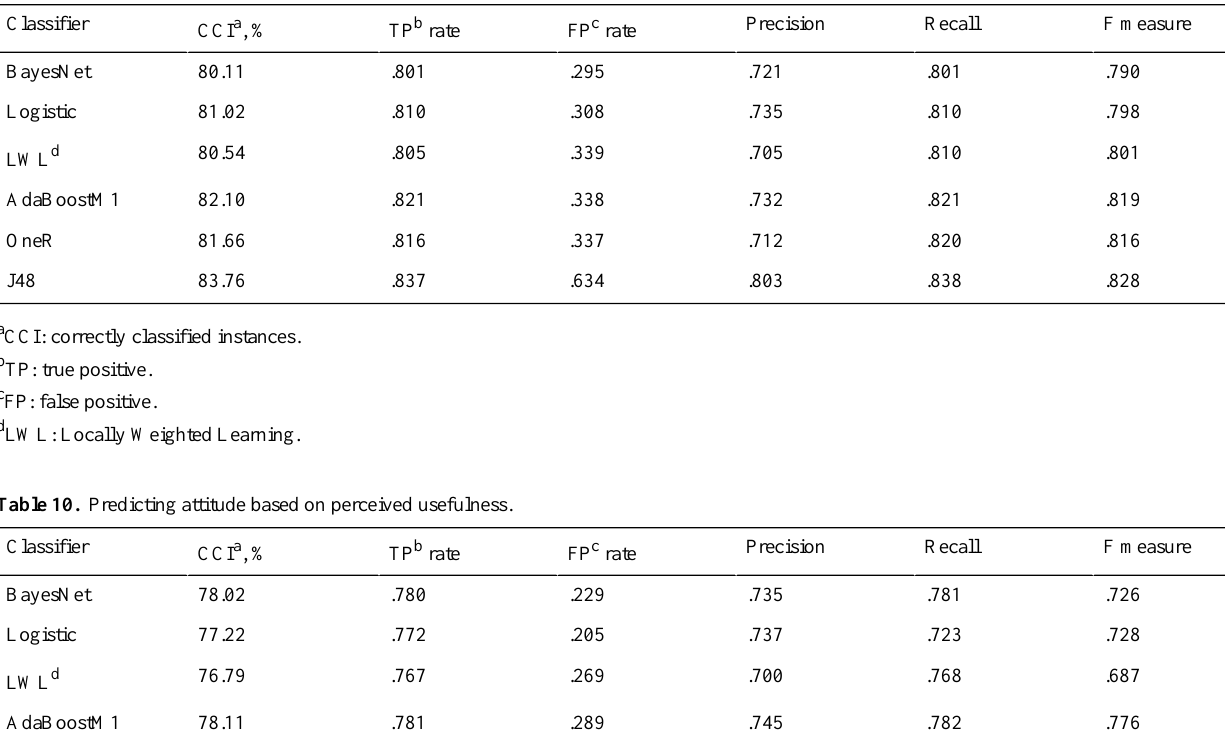
Table 9. Predicting perceived usefulness based on the perceived ease of use and perceived fear.